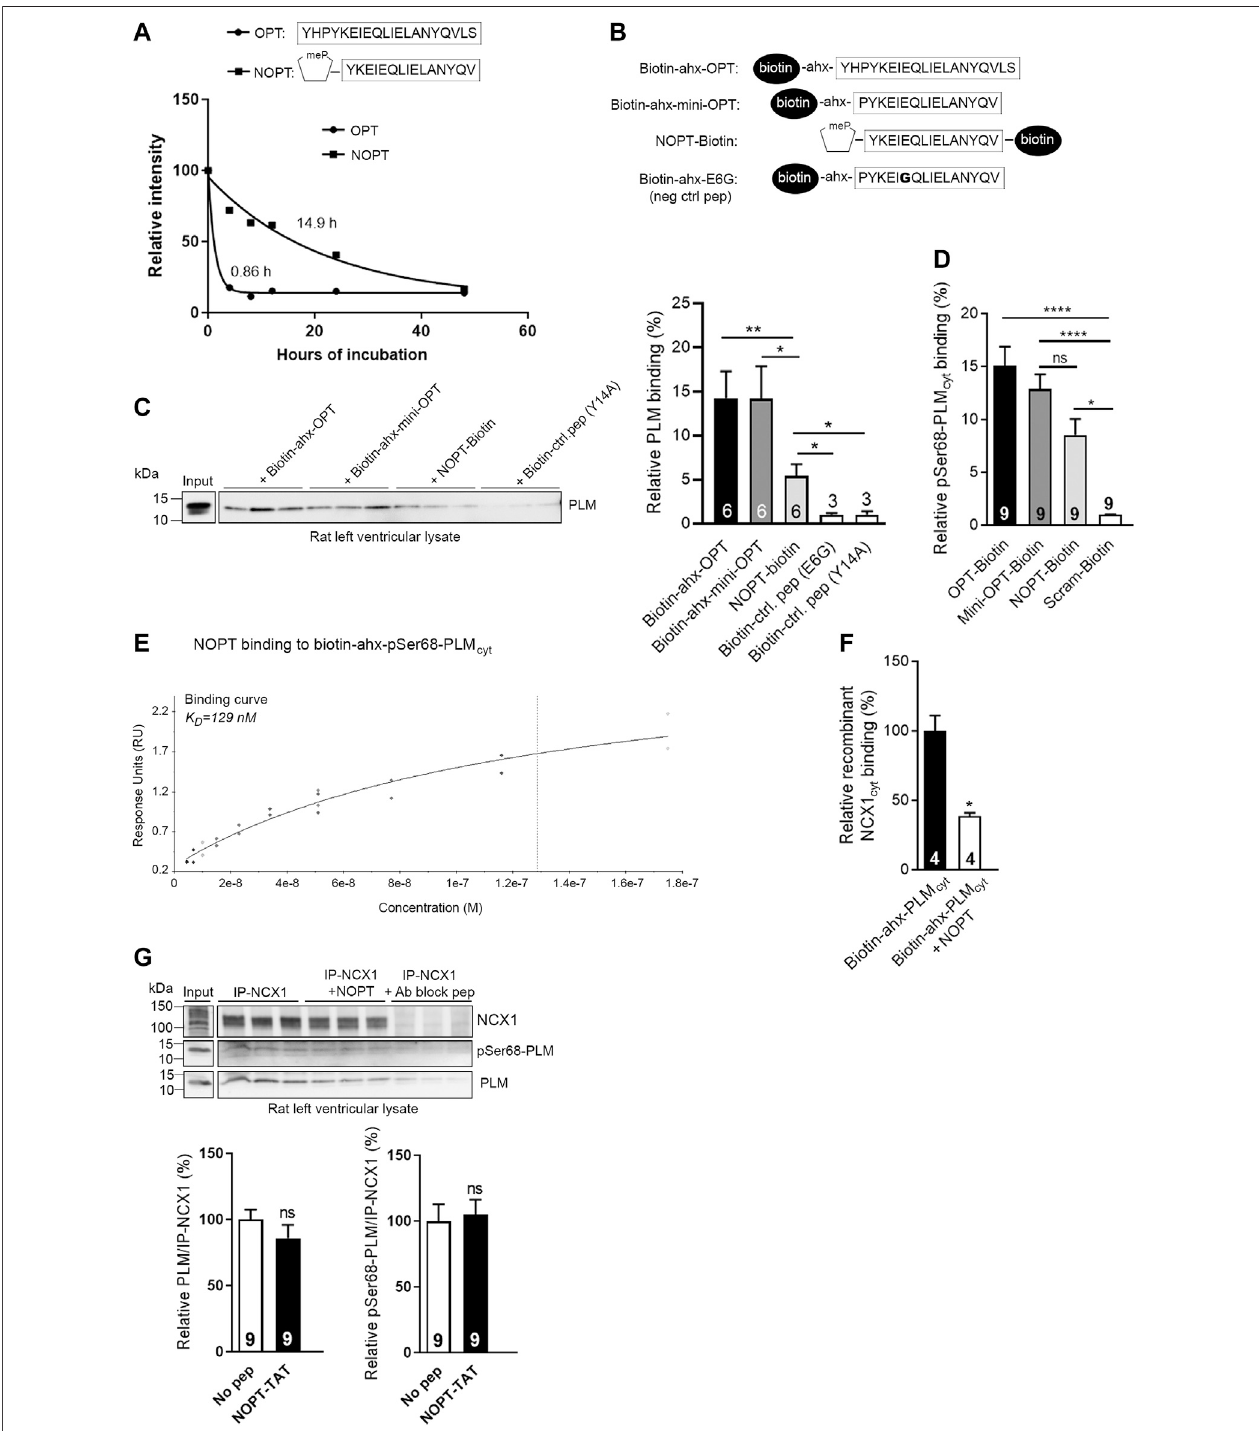
FIGURE 3 | Analyses of peptide stability in human serum and PLM binding capacity of NOPT. (A) Stability of OPT (black circles) ( n (cid:2) 4) and NOPT (black squares) ( n (cid:2) 3 – 7) in 30% human serum analyzed by mass spectrometry. The relative intensity of the full length peptide/total intensity is given vs. hours of incubation and set to 100%at0 h. (B) Illustrationofthepeptidesusedinthepulldownexperimentin (C) . (C) Pulldownassaywithbiotin-ahx-OPT,biotin-ahxmini-OPTandNOPT-biotininrat leftventriclelysate[peptidesillustratedin (B) ].ExceptforNOPT,thebiotintagwasaddedattheN-terminusofthepeptides.Anahx-linkerwasincludedtoavoidany potential steric hindrance. Endogenous PLM was detected with immunoblotting with PLM antibodies. * p < 0.05, ** p < 0.01, examined by Mann-Whitney test ( n (cid:2) 3 – 6 rats, mean with SEM). Mini-OPT-E6G and mini-OPT-Y14A were used as negative control peptides (identi fi ed in Figure 2E , red circles). (D) Analyses of OPT-biotin,